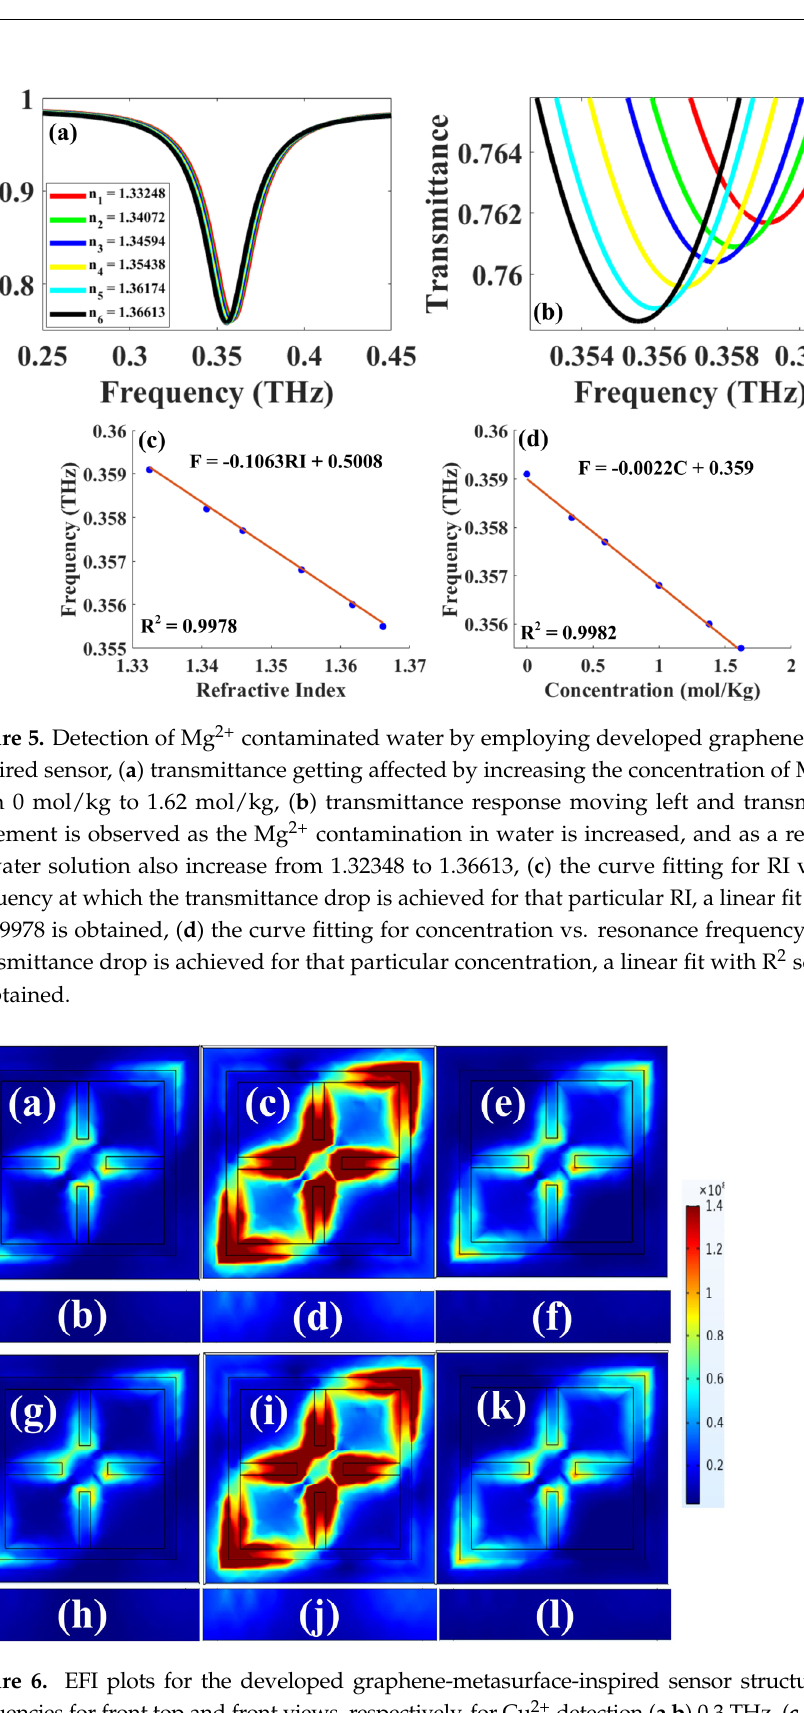
Figure 6. EFI plots for the developed graphene-metasurface-inspired sensor structure at various frequencies for front top and front views, respectively, for Cu 2+ detection ( a , b ) 0.3 THz, ( c , d ) 0.3582 THz, ( e , f ) 0.4 THz, for Mg 2+ detection, ( g , h ) 0.3 THz, ( i , j ) 0.3577 THz, ( k , l ) 0.4 THz.